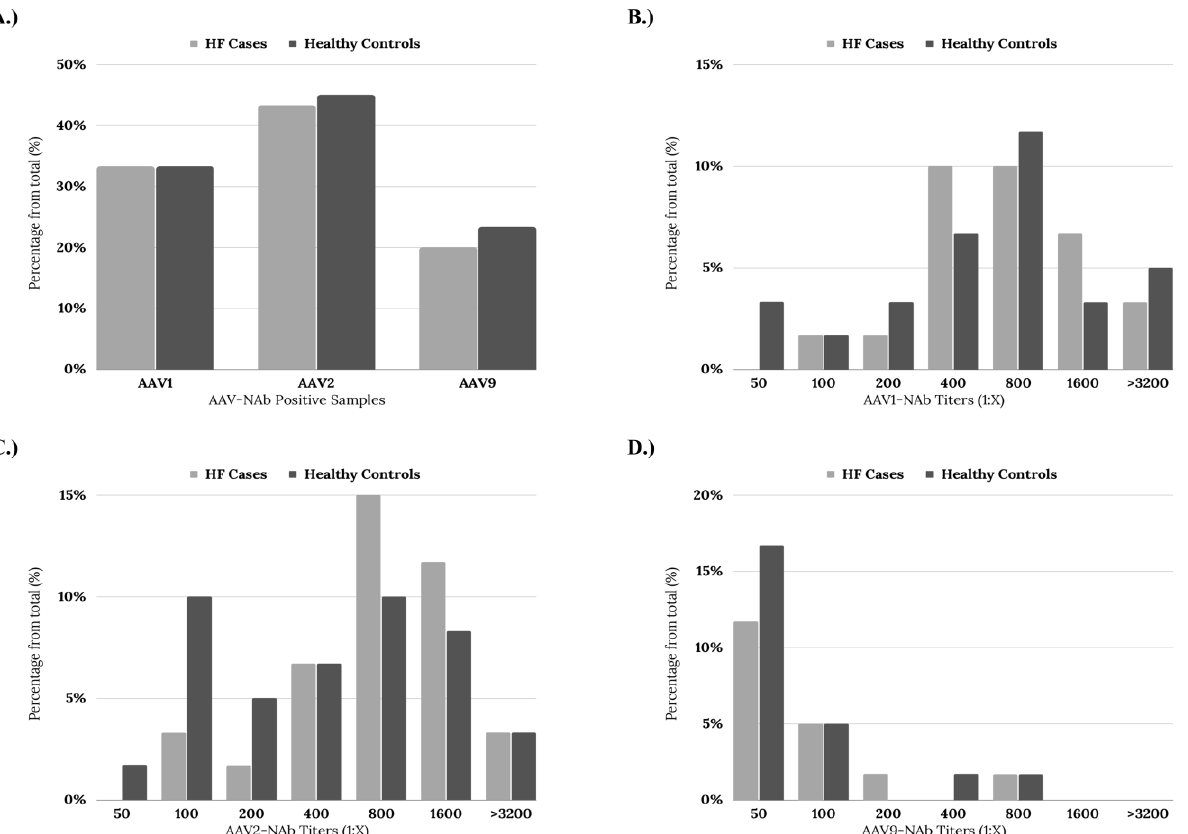
Figure 2. ( A ) Bar graph summarizing the prevalence of Nab against each AAVs according to the group. Bar graph of the prevalence of NAb against each AAVs according to the titer measured ( B ) anti-AAV1 NAb titers. ( C ) anti-AAV2 NAb titers. ( D ) anti-AAV9 NAb titers.